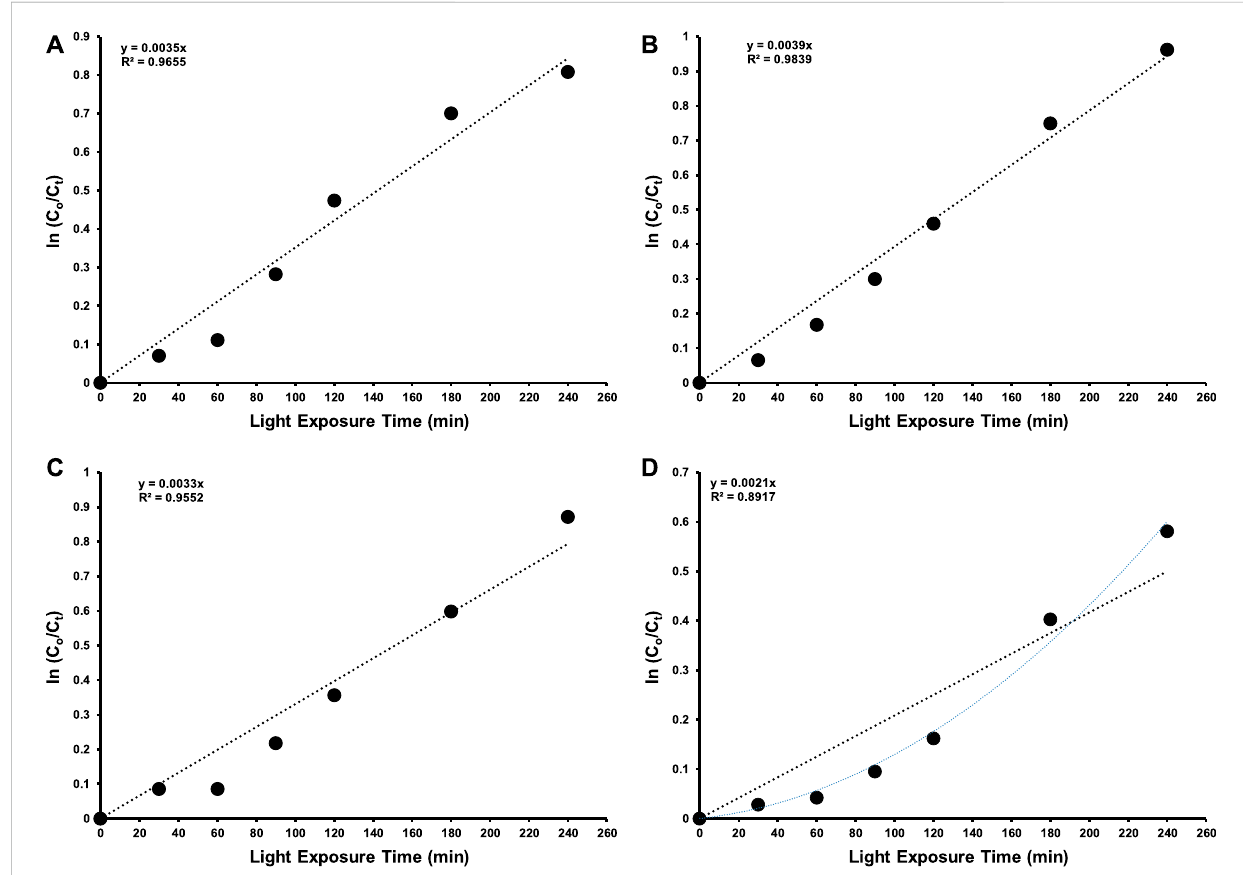
FIGURE 8 Rateofremovalof15 ppm2-CPover (A) CeO 2 (B) FedopedCeO 2 (C) CudopedCeO 2 and (D) NidopedCeO 2 atdifferentintervalsoftimeunderthe illumination of indoor white light (800 × 10 2 lx).